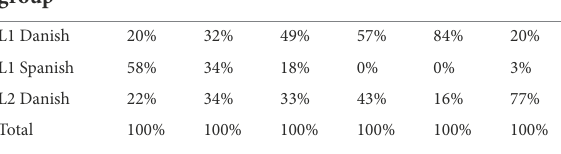
TABLE 4 Relative frequency of type of construction across participant groups. Language